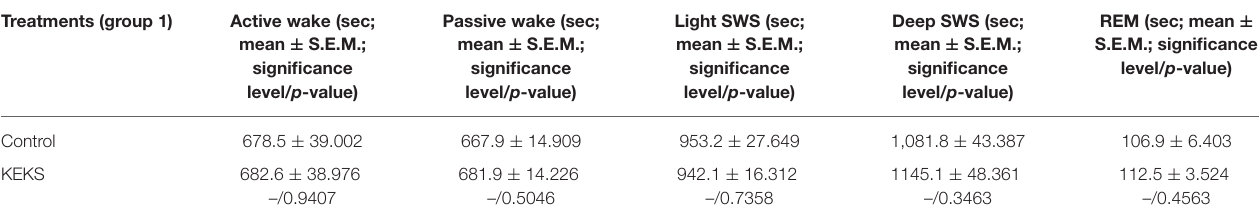
TABLE 3 | Effect of KEKS food (20% KEKS and 1% saccharin in standard rodent chow; group 1) on total time of sleep-waking stages on 9th KEKS treatment day between 30 and 90min. Treatments (group 1) Active wake (sec; mean ± S.E.M.; significance level/ p